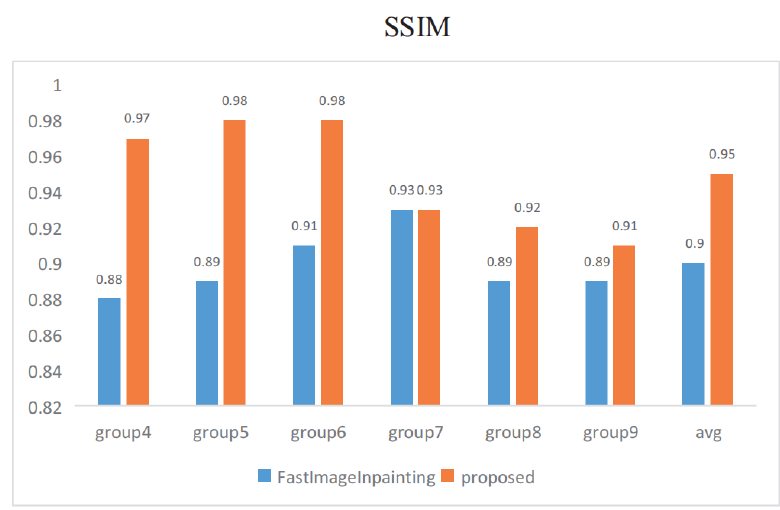
Figure 11. Quantitative results in terms of SSIM on